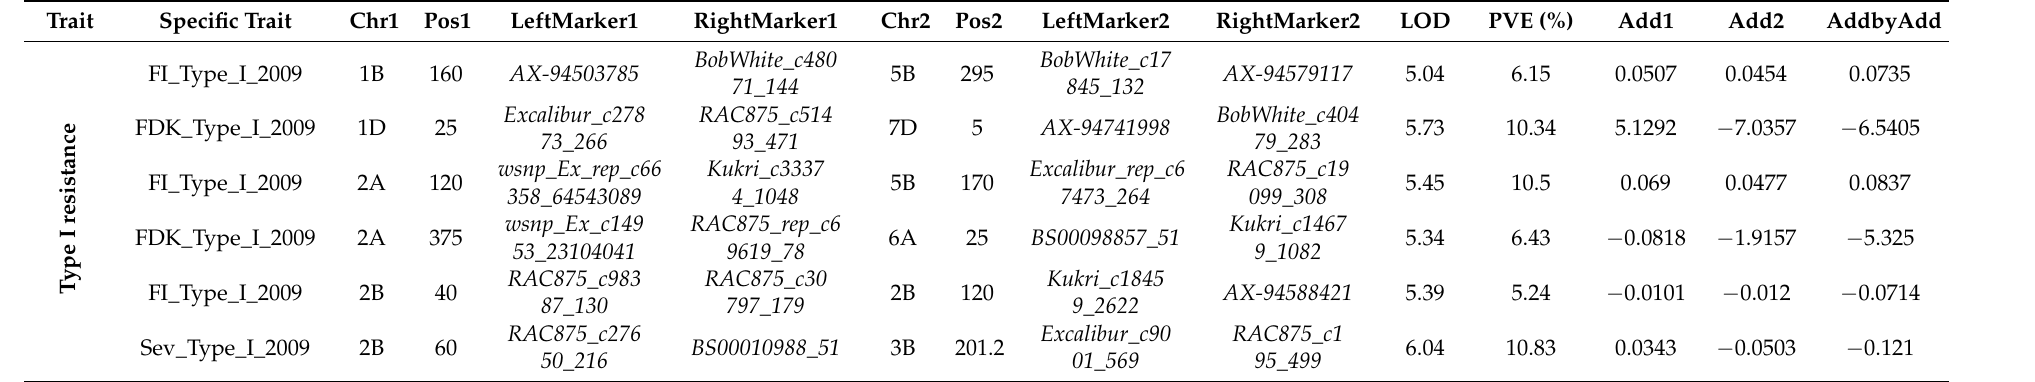
Table 3. Pairs of epistasis QTLs detected in the ITMI/MP. Markers in bold are involved in multiple